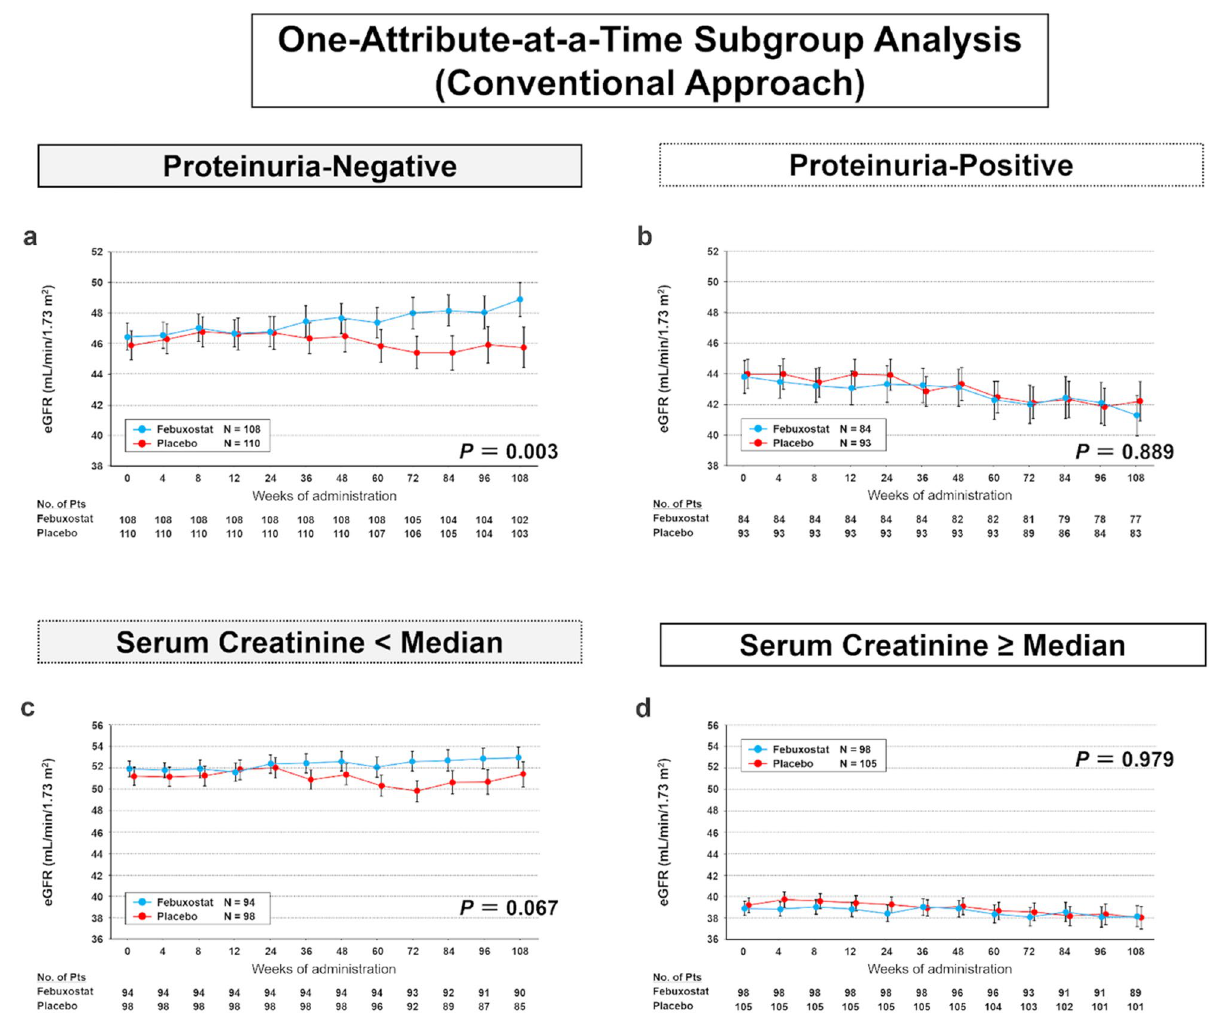
Figure 3. Time-course changes in the estimated glomerular filtration rates (eGFRs) from week 0 through week 108 of treatment. ( a ) Subcohort of patients without proteinuria. ( b ) Subcohort of patients with proteinuria. ( c ) Subcohort of patients with serum creatinine level < median. ( d ) Subcohort of patients with serum creatinine level ≥ median. The mean eGFR in the two groups is shown at different timepoints during the trial. Error bars indicate the standard error. The mean eGFR is shown for participants with available levels at each timepoint. P -values were obtained by a test of the trend profile using a mixed